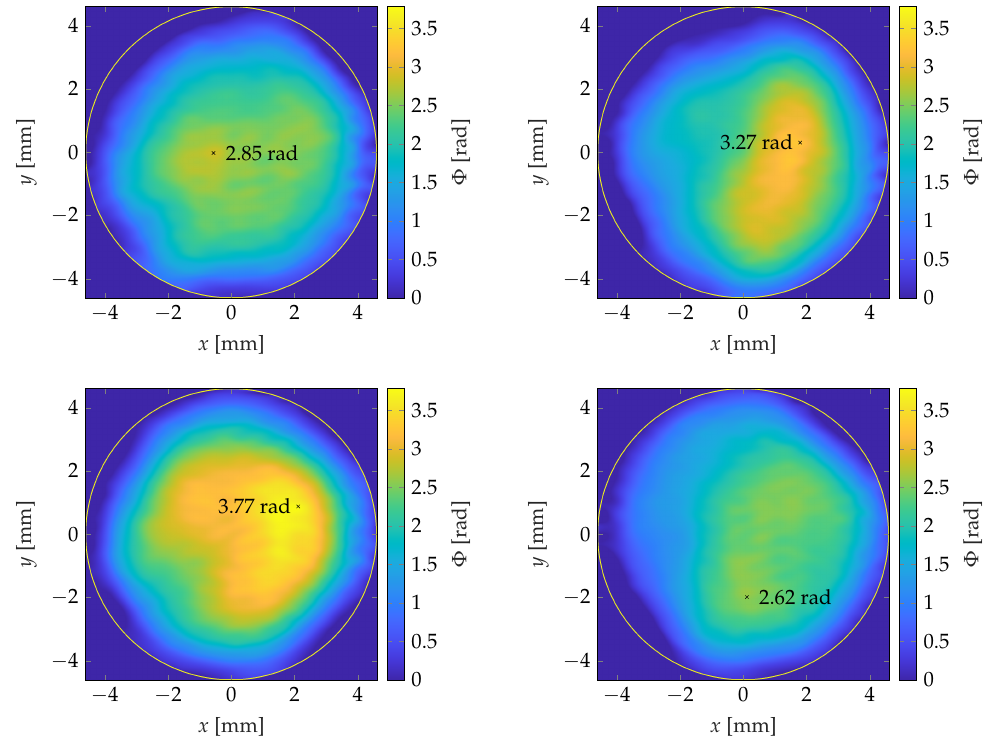
Figure A1. Spatial distributions of the phase shift Φ ( x , y ) inside the tube resulted in 4 consecutive shots with the highest values